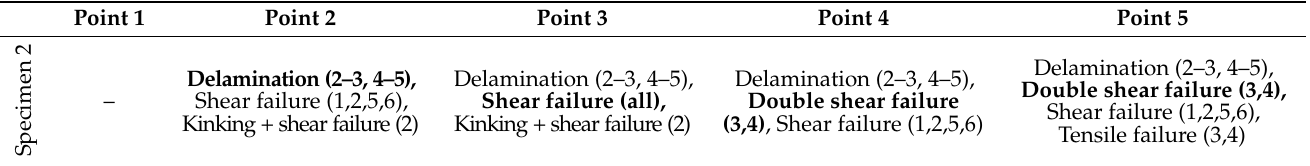
Table 1. All failure modes observed in specimen 2.